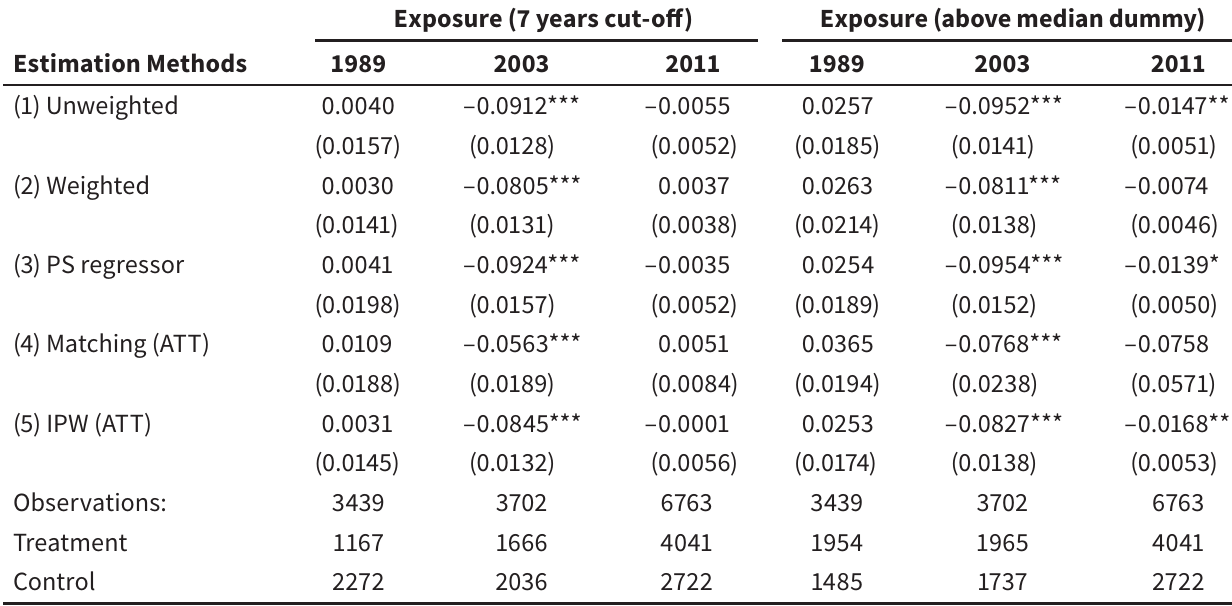
The Impact of Conflict on the Gini Coefficient using Alternative Conflict Measures